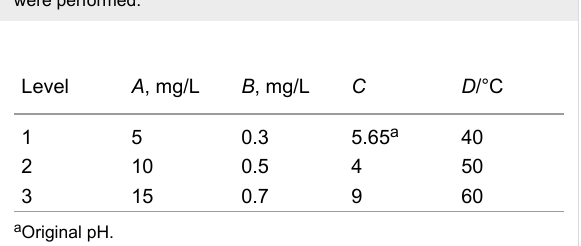
Table 4: Table of experimental factors for the orthogonal table of L9 (34). Nine experiments with different concentrations of RhB ( A ,